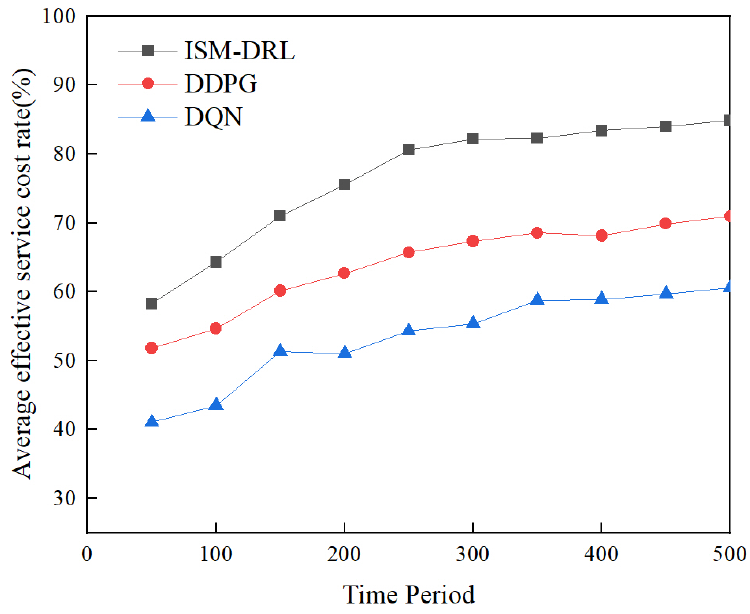
Figure 5. Average effective service cost rate at α 1 = 0.7, α 2 = 0.3. Table 5. Average effective cost rate at T =